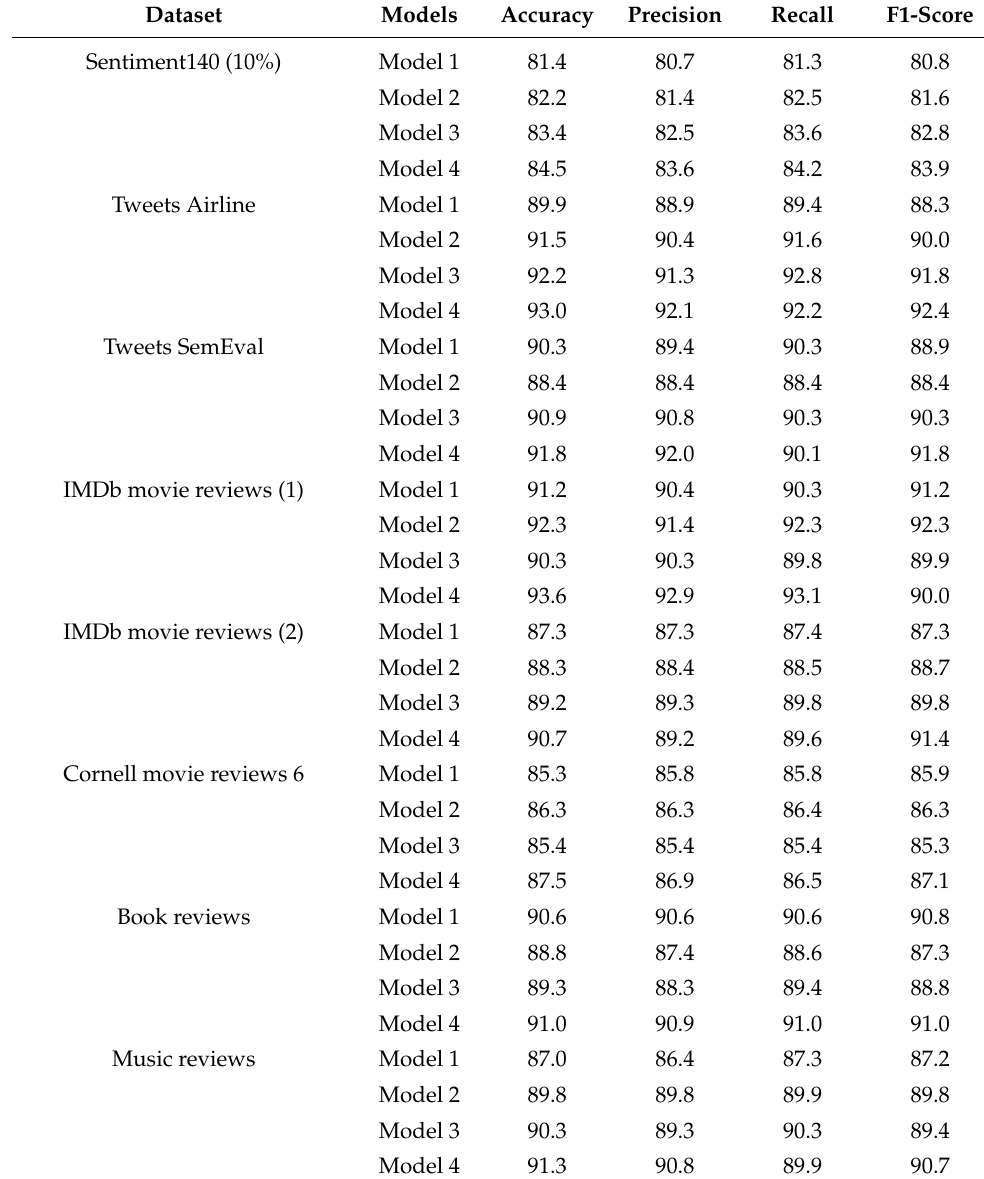
Table 6. The results of four models for different types of